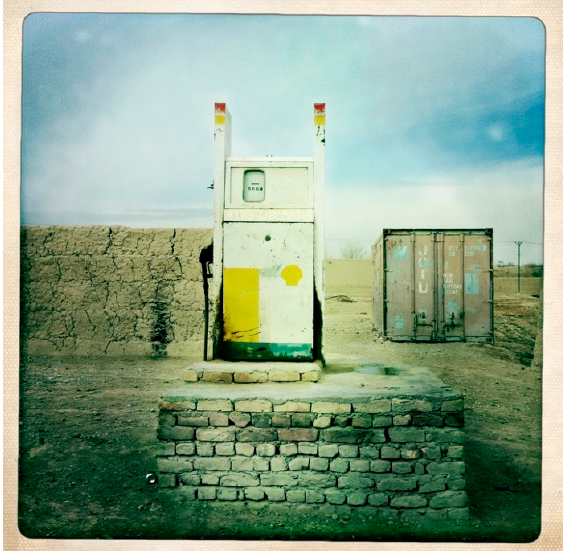
Figure 5. Fuel dispenser. Source: created by Rita Leistner (used with photographer’s permission).